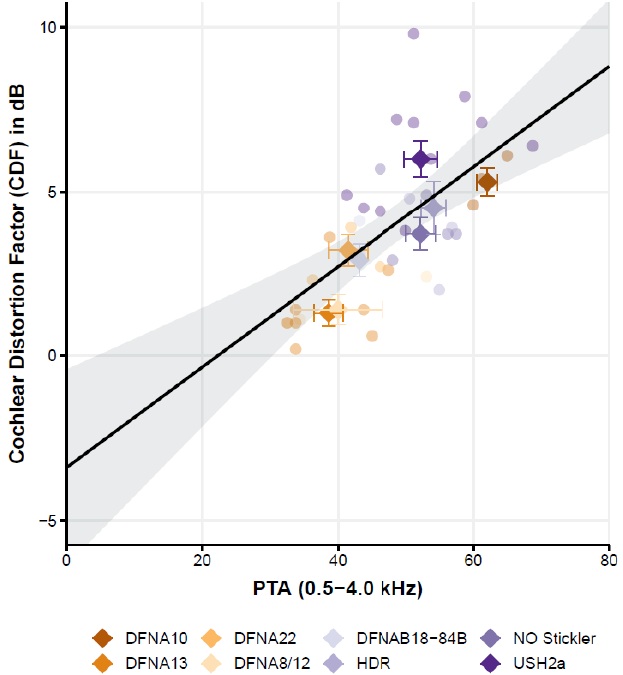
Figure 3. Cochlear distortion factor (CDF) as a function of the hearing loss (PTA) of the eight patient groups (individual data shown as circles where each patient group has a different color. The average for each patient group across PTA and CDF is indicated by a diamond-shaped symbol). The linear regression line presents the calculated best-fit curve and the 95% confidence interval of the fit.